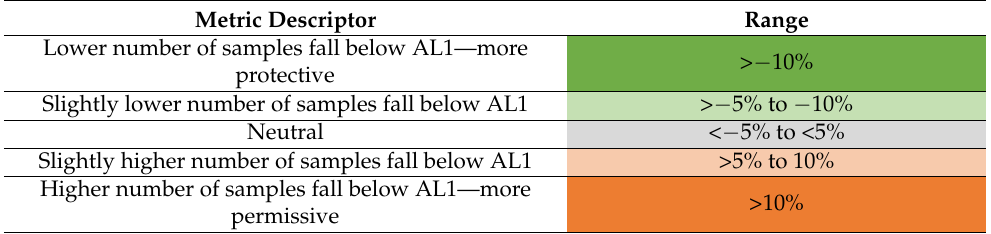
Table 2. Metrics used to interpret scenario comparisons with the current